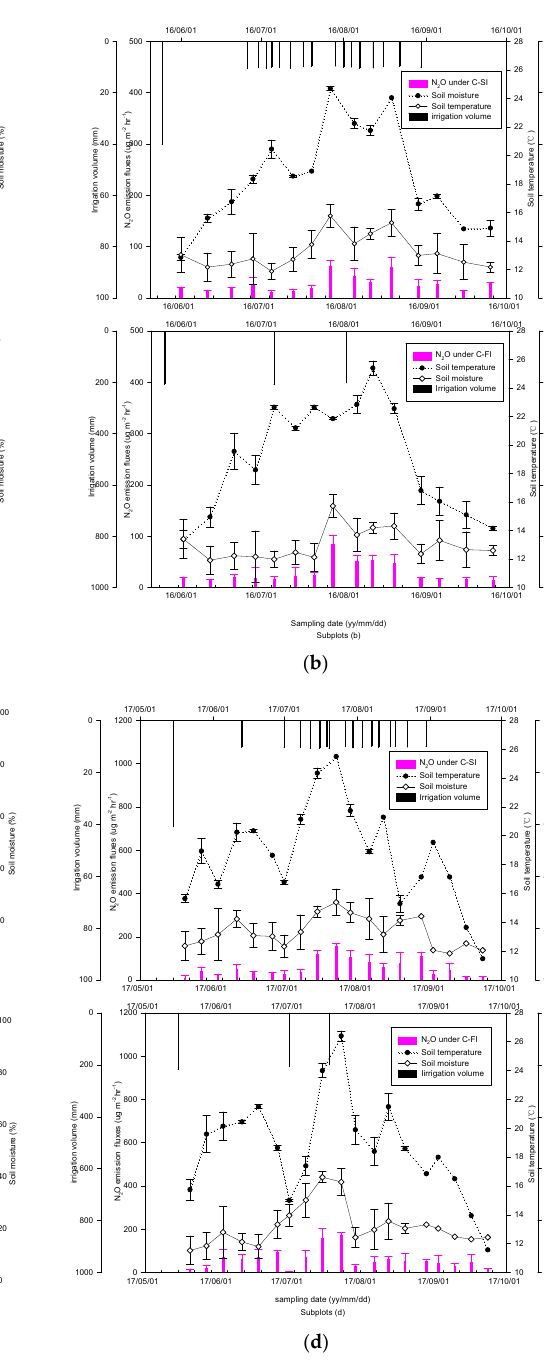
Figure 2. Relationship between the variation in N 2 O emission fluxes and the soil moisture or soil temperature in subplots ( a ), ( b ): Control (C) and nitrogen fertilizer (NF) under flood irrigation (FI) and sprinkler irrigation (SI) in 2016. ( c ), ( d ): Control and NF from FI and SI in 2017. Vertical bars indicate the mean and standard error. The y-axes in graphs ( a – d ) are on different scales.